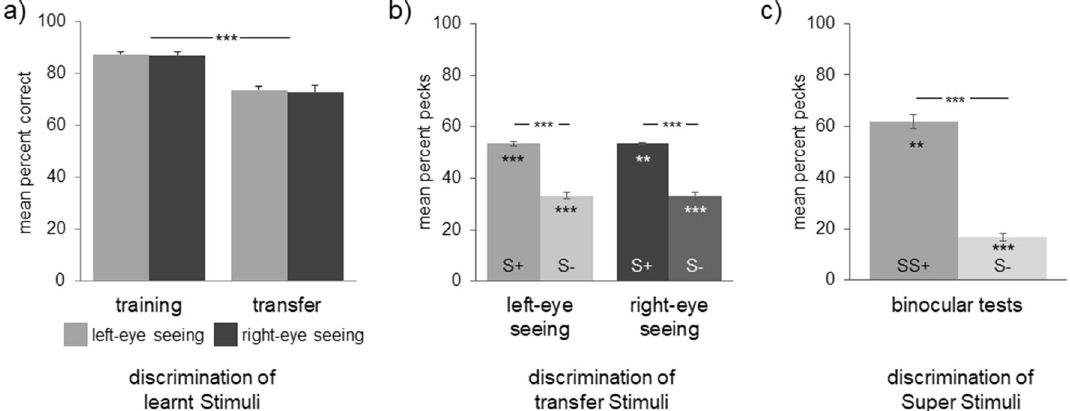
Figure 2. Discrimination of the stimulus classes—( a ) Discrimination accuracy of learnt stimuli during training and transfer tests expressed as the percentage of trials responded correctly; ( b ) percent pecks onto positive (S+) and negative (S−) untrained stimuli during transfer tests; ( c ) percent pecks onto positive (SS+) and negative (S−) stimuli during binocular conflict tests. SS+ stimuli include at least one dog and one cat and are hence, positive for both hemispheres. Bars represent standard error (** p < 0.01, *** p < 0.001 according to t-tests for dependent samples or one sample